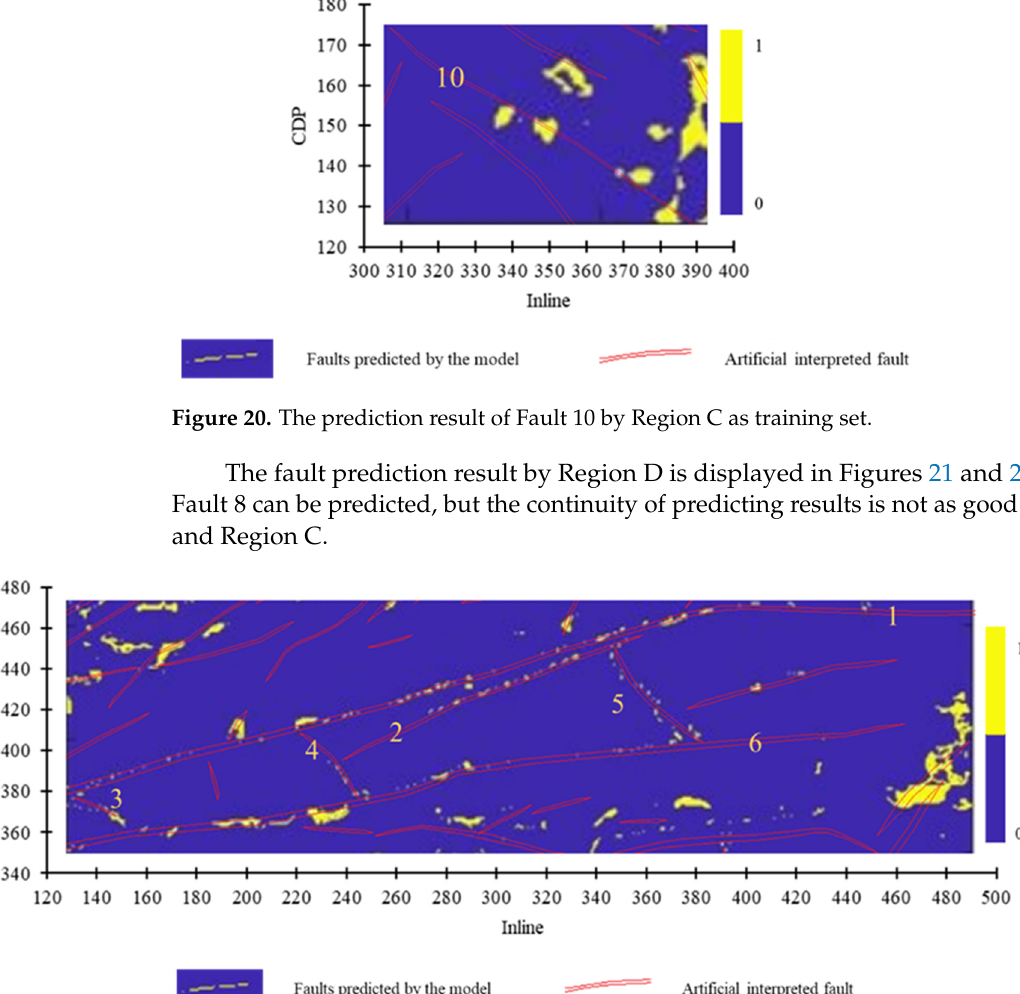
14 of 18 Figure 18. The prediction result of Faults 1–6 by Region C as training set.